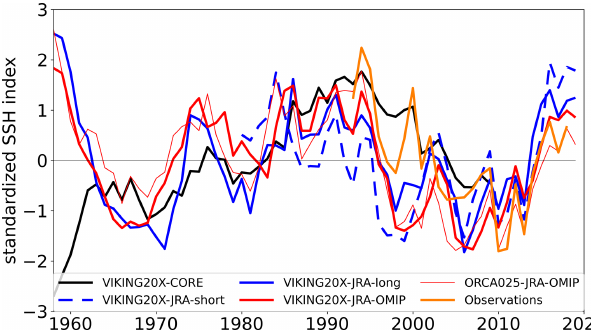
Figure 10. Time series of the annual mean subpolar gyre index in the experiments and based on observations (orange). Here, the in- dex is defined as the second principle component of an empirical orthogonal function analysis for non-detrended SSH in the North Atlantic between 20 and 70 ◦ N.